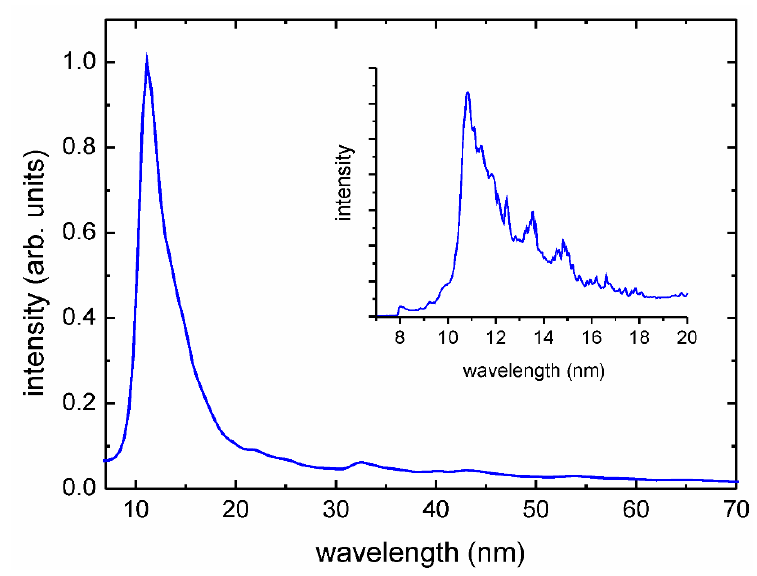
Figure 1. The spectrum of the extreme ultraviolet (EUV) radiation emitted from laser-produced plasma (LPP) Xe plasmas and focused by the ellipsoidal collector. In the inset, the most intense part of the spectrum, measured with higher resolution, is presented.